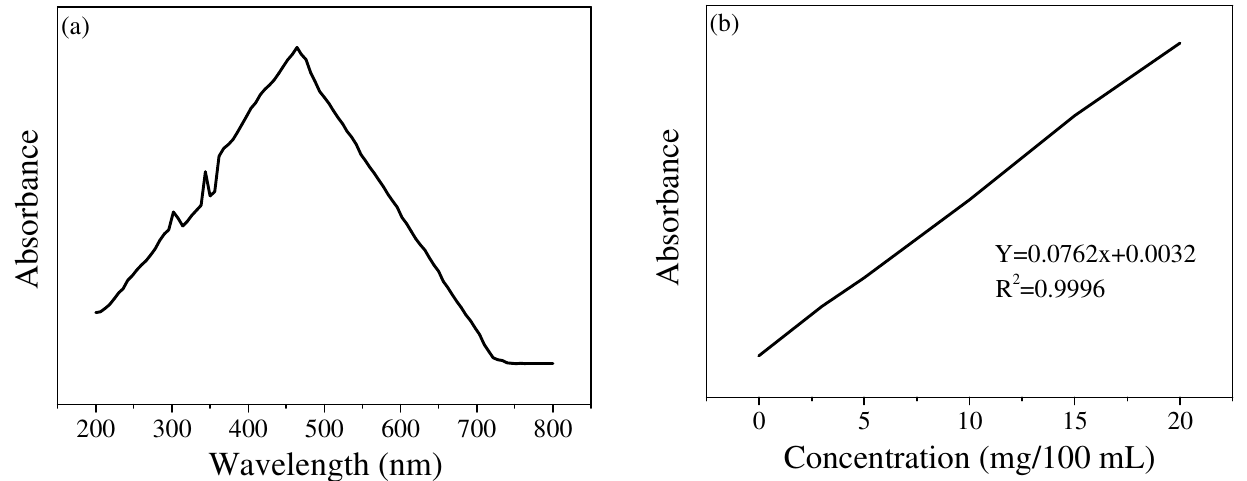
Figure 12. UV-Vis spectra of methyl orange at different ( a ) wavelengths and ( b ) concentrations.